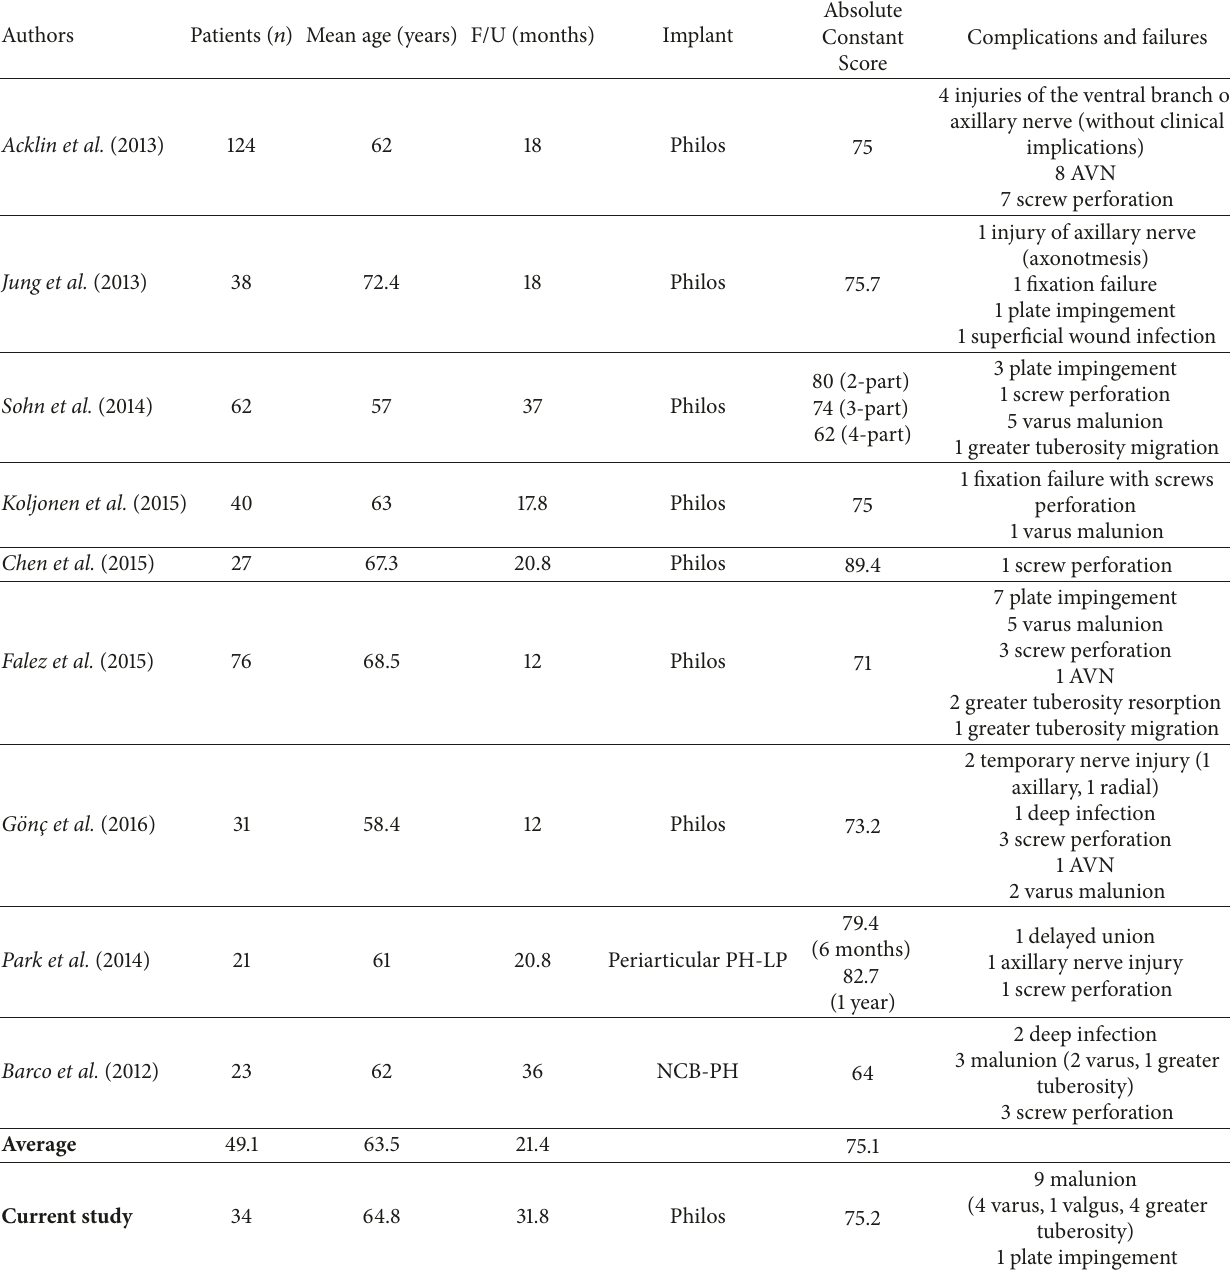
Table 5: Comparison of clinical results and complications reported with the MIPO